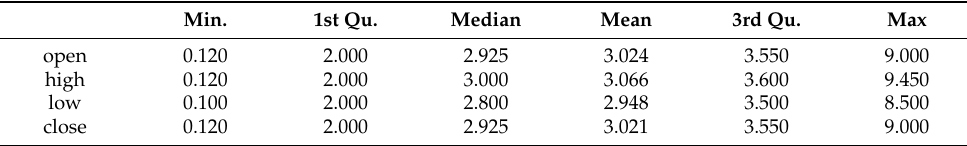
Table 3. Descriptive statistics of the stock data.